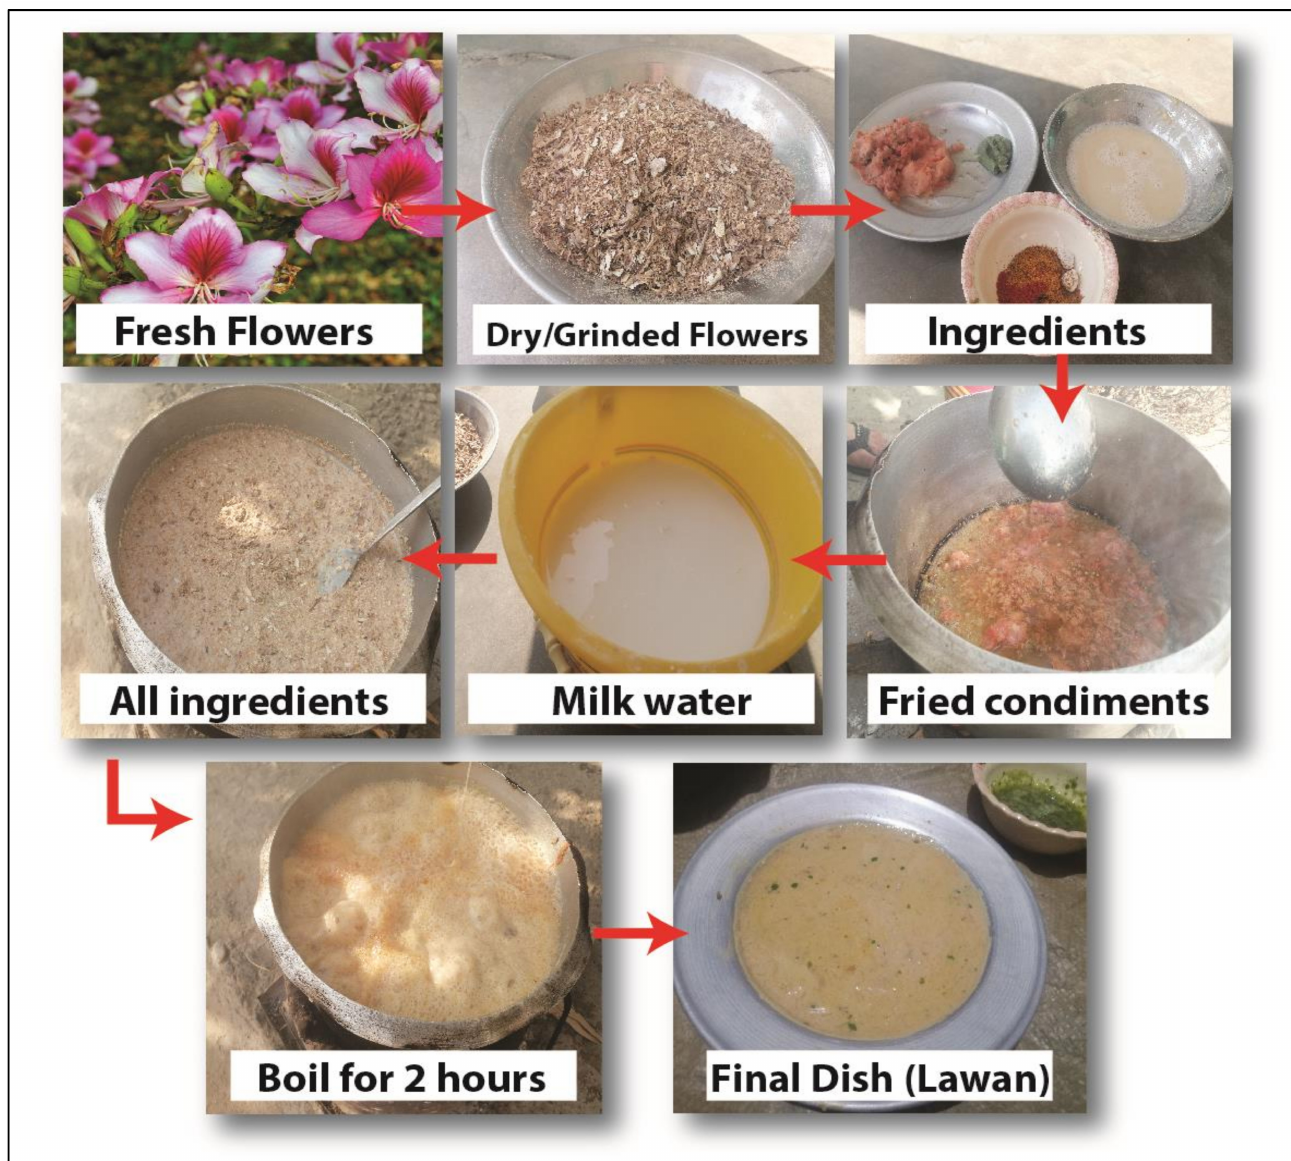
Figure 8. The various steps in the preparation of